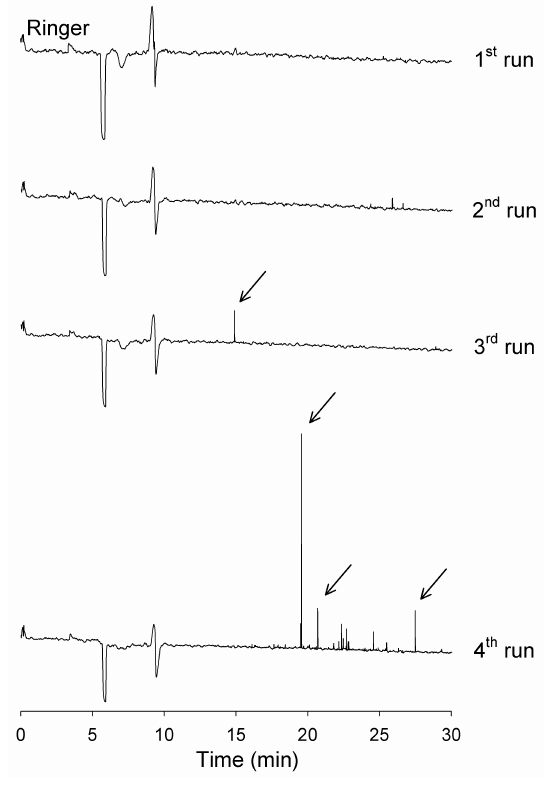
Figure 2. Successive analysis of 30 kDa ultra-filtered Ringer. Running buffer as in Figure 1. Injection 0.5 psi/20 s. Spikes (arrow) appeared in the third run and became abundant in the fourth run.